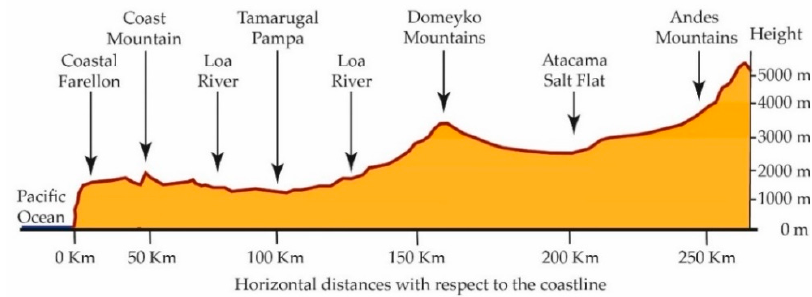
Figure 1. Chile’s Great North Topographic Profile 22° and 23° South Latitude.